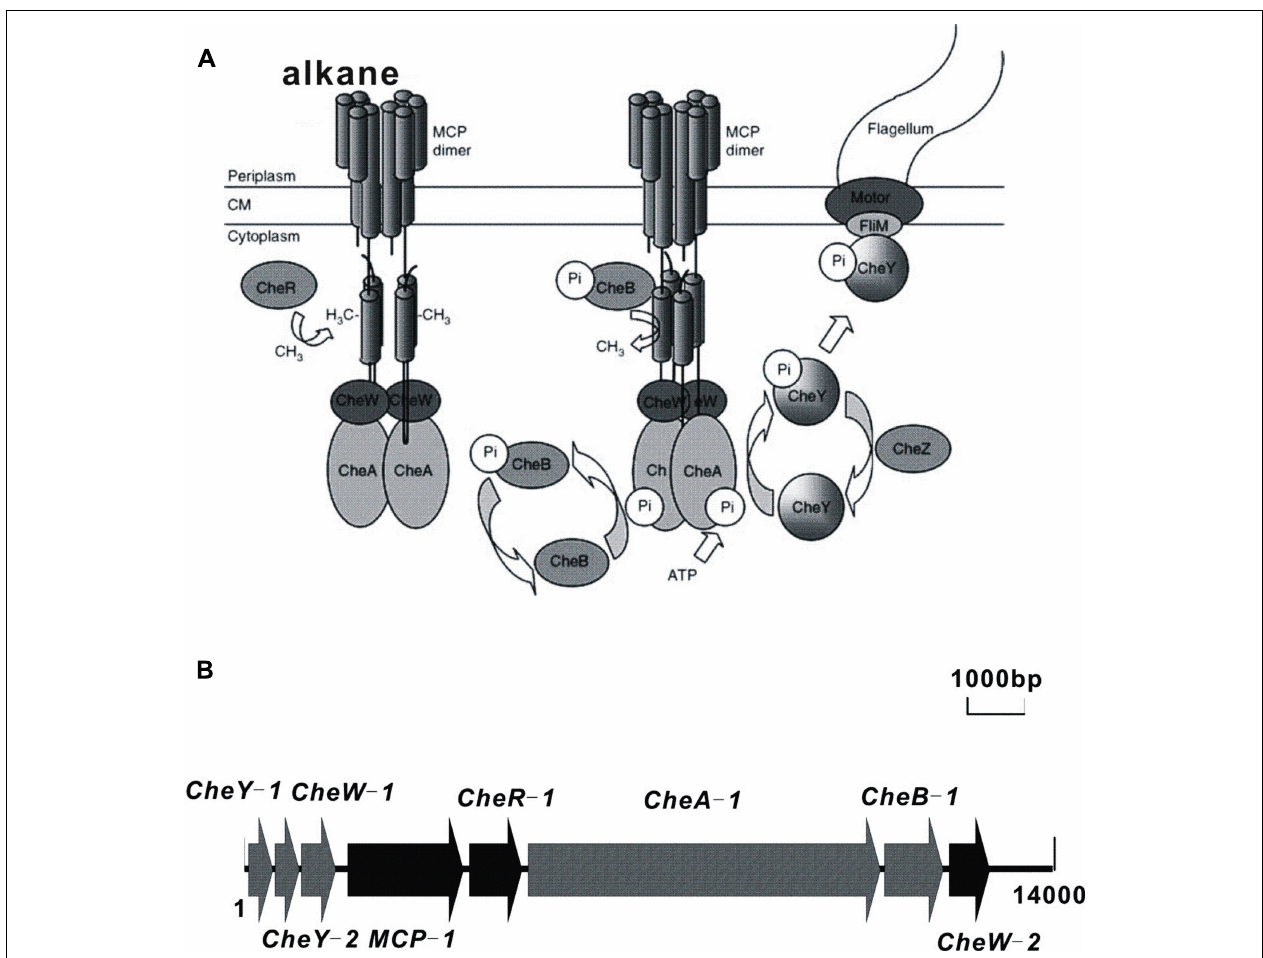
FIGURE 1 | Schematic diagram of the chemosensory signaling system of A. dieselolei B-5. (A) MCP dimers with associated CheW and CheA proteins are shown in the presence (left) and absence of alkane (right). Cells responding to a gradient of attractant will sense the attractant bound to the periplasmic side of the cognate MCP and will continue swimming in the favorable direction due to the inability of CheA to autophosphorylate. In the absence of CheA-P, CheY remains in the inactive unphosphorylated state, and swimming behavior remains unchanged. Cells swimming down a gradient of attractant will sense the decrease in attractant concentration due to decreased occupancy of the MCPs. Under these conditions, the MCPs undergo a conformational change that is transmitted across the cytoplasmic membrane and stimulates CheA kinase activity. CheA-P phosphorylates CheY, which in its phosphorylated state binds to the FliM protein in the flagellar motor and causes a change in the direction of flagellar rotation allowing the cell to randomly reorient and swim off in a new